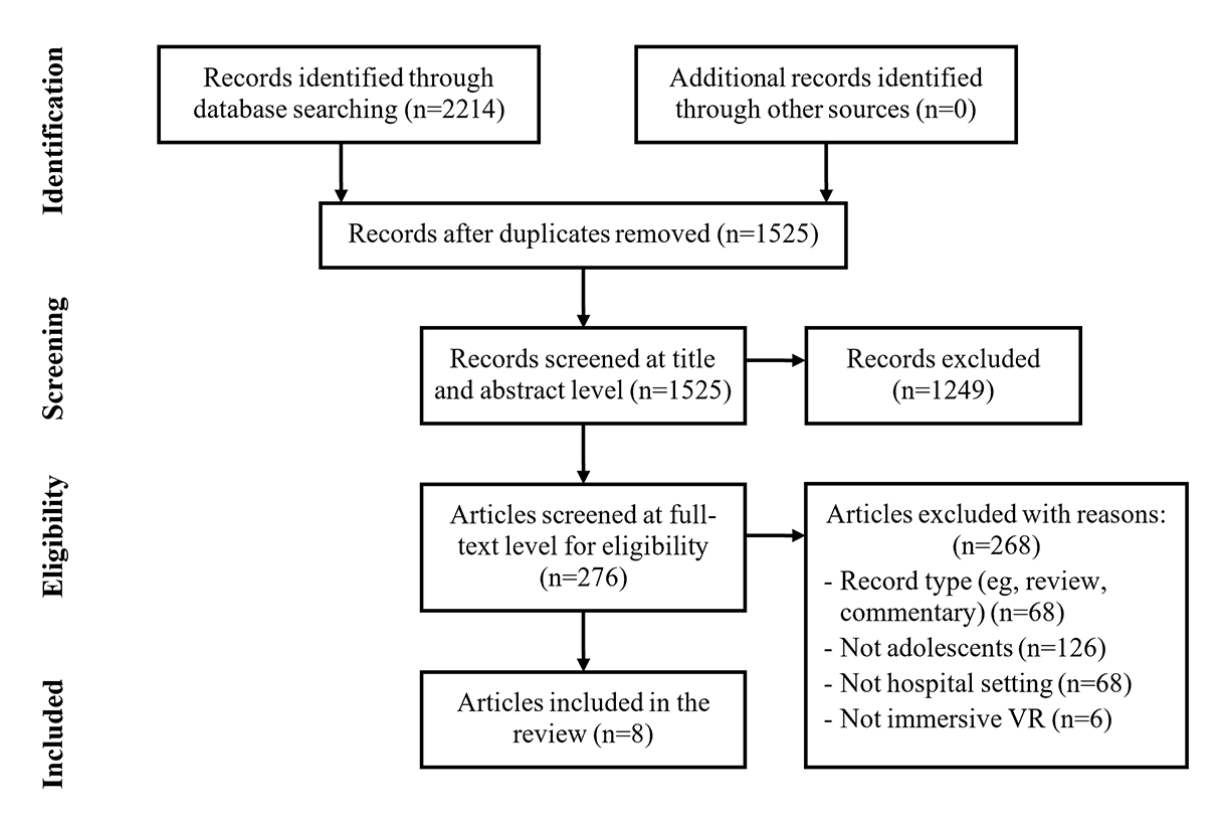
Figure 1. Selection